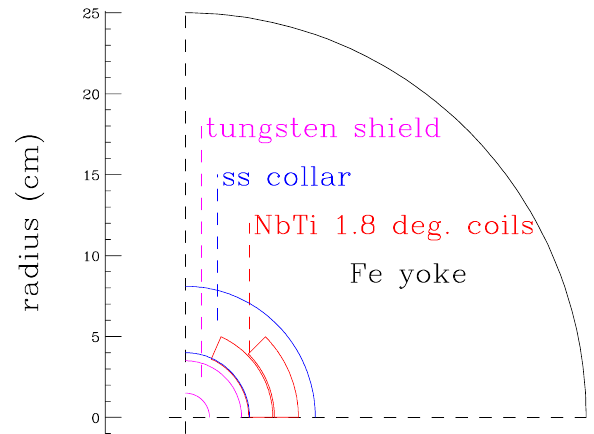
FIG. 54. (Color) Cross section of a baseline dipole magnet suitable for the 100 GeV